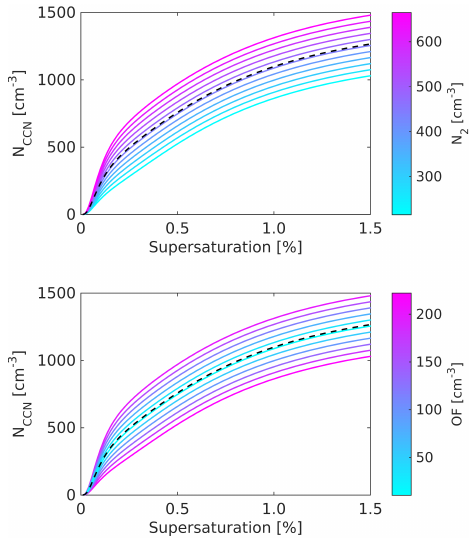
Figure 4. Rural continental CCN spectra for partitioning scheme a np w σ f . In the top panel, the colour mapping indicates modelled CCN spectra as a function of N 2 within uncertainty ranges speci- fied in Table 2. In the bottom panel, the colour mapping indicates variation in the OF between the modelled spectra and the calibra- tion data (dashed black line) for the corresponding calculations with respect to N 2